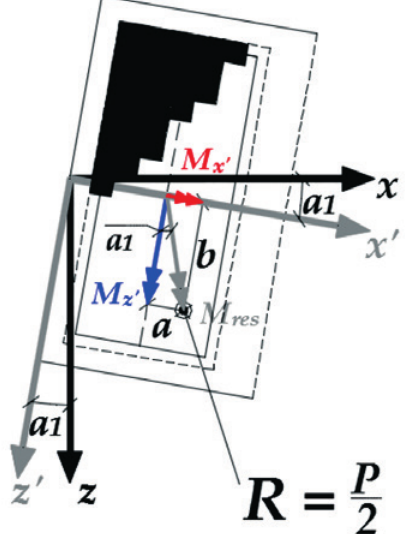
Momentos fletores gerados pela reação de apoio na almofada Fonte: Autores (2017)